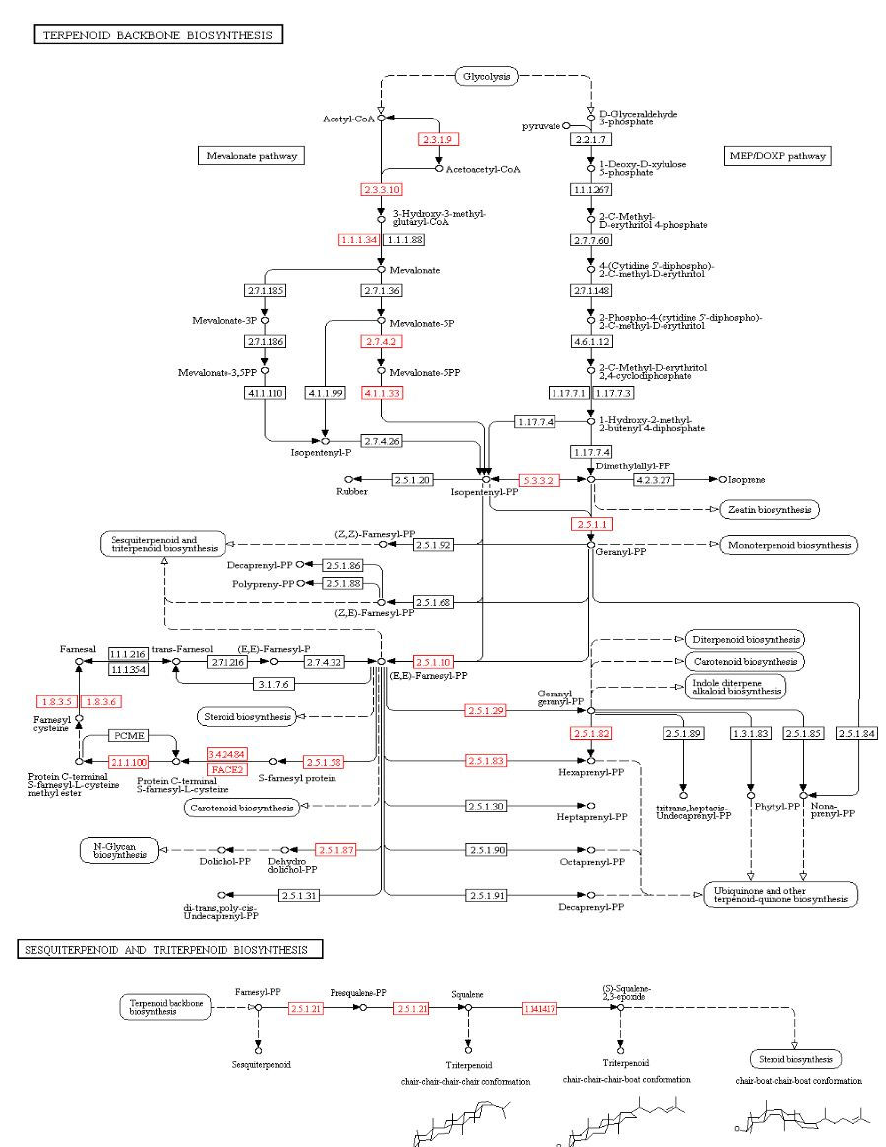
Figure 4. “Terpenoid backbone biosynthesis” (KEGG: ko00900) and “sesquiterpenoid and triterpenoid biosynthesis” (KEGG: ko00909) pathways of G. incarnatum . Red boxes indicate the presence of the enzymes, whereas white boxes indicate enzyme is not